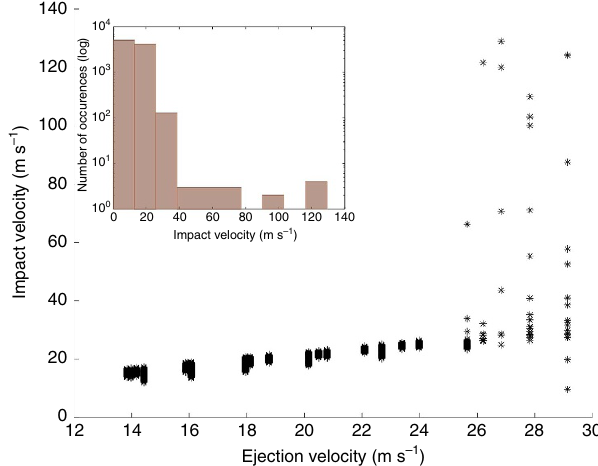
Figure 3 | Impact versus ejection velocity for sesquinary impactors. Ejecta correspond to simulations in all panels of Fig. 5. The majority of impacts occur at a velocity comparable to their ejection velocity, that is, between 11 and 30ms (cid:3) 1 . However, a small fraction experience acceleration due to greater interactions with Mars’ gravity (inset); these have a correspondingly longer accretion time. On the basis of these results, sesquinary impact craters are largely expected to have an appearance similar to secondary craters noted in image surveys of